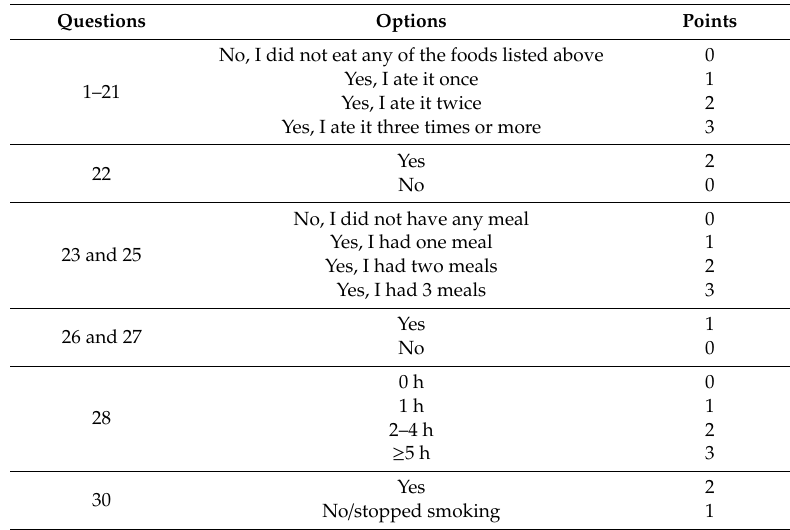
Table A3. Scoring system for total adherence score calculation.